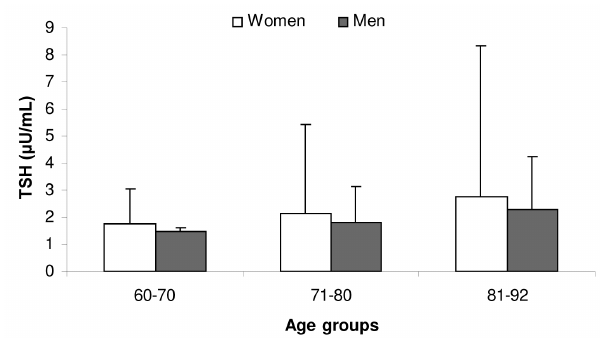
Figure 1 - TSH levels within age groups. Note the increasing TSH values with age in men and women